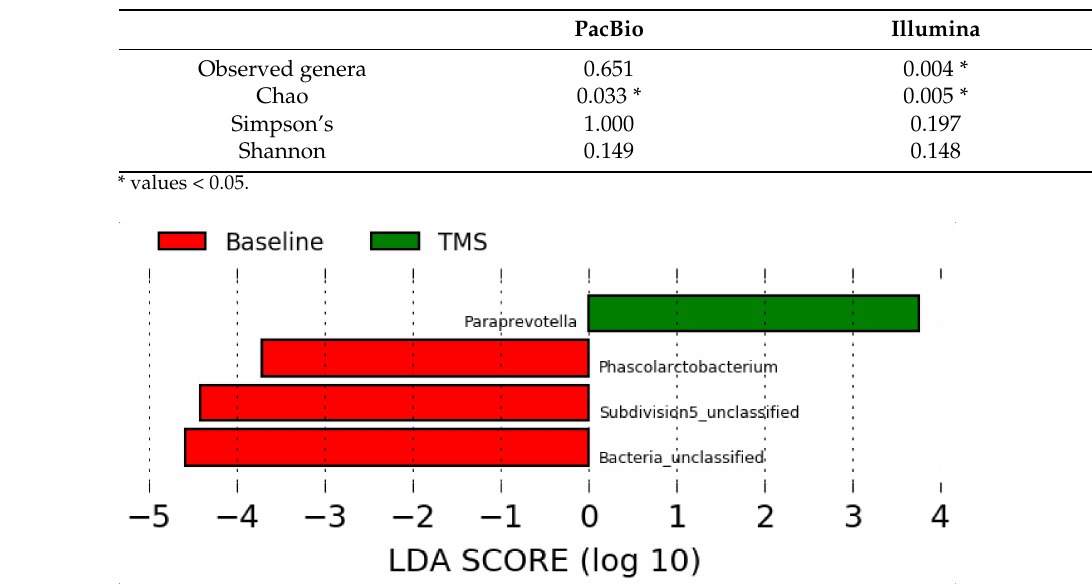
Table 2. P values obtained from a t -test comparing the impact of antimicrobial administration on alpha diversity indices evaluated by two different sequencing technologies (PacBio and Illumina).